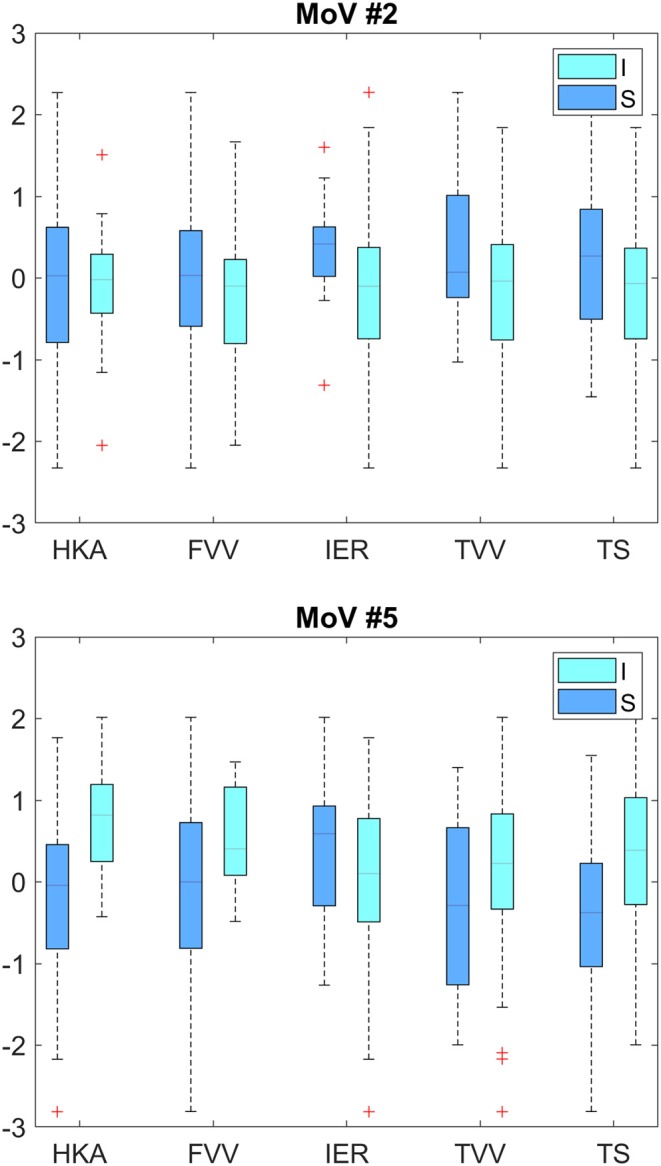
Box plots for MoV #2 and #5 distributions across mechanically stable and unstable cases. Upper plot—HKA (p = 0.90), VVF (p = 0.08), IER (p = 0.02), VVT (p = 0.08), and TS (p = 0.06). Lower plot—HKA (p = 0.0005), VVF (p = 0.01), IER (p = 0.13), VVT (p = 0.09), and TS (p = 0.002). I, Instability; S, Stability.